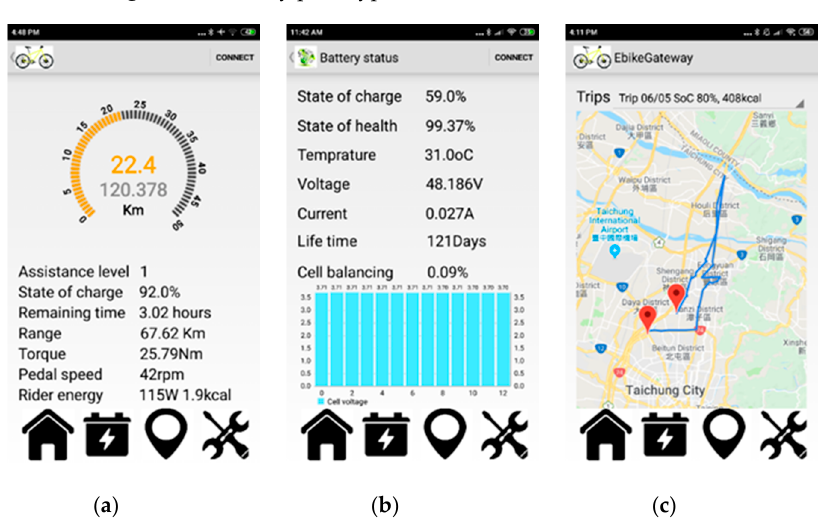
Figure 9. Gateway prototypes. ( a ) Version 1.0. ( b ) Version 2.0.